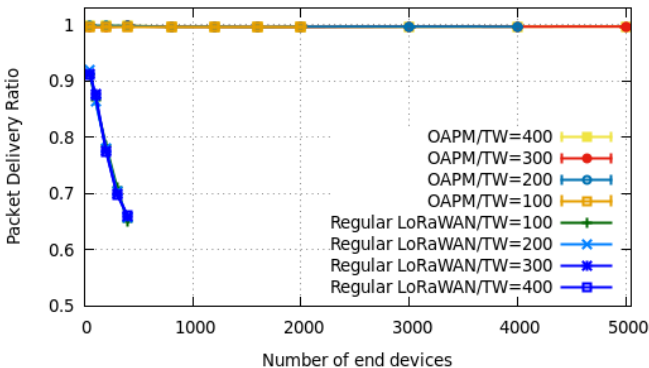
Figure 11. Impact of time window duration on PDR using 8 Receive Paths.